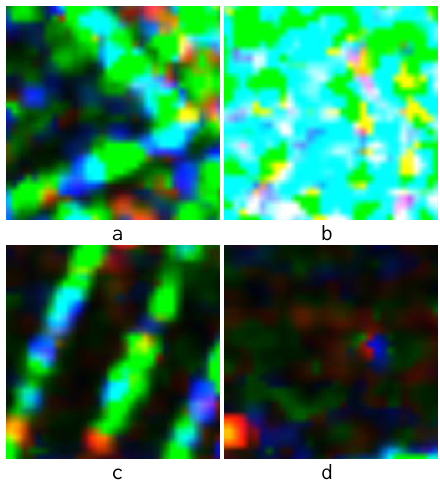
Figure 6. Sample diagram of 1m resolution.